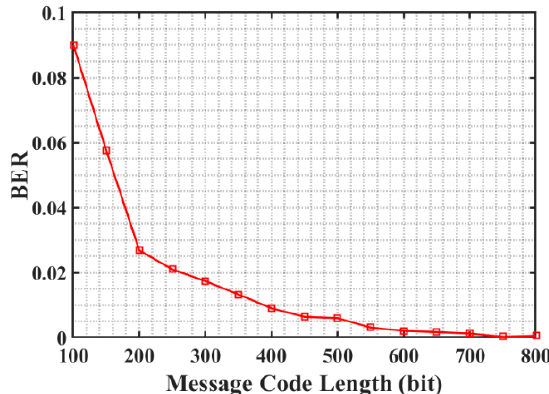
Figure 5. Variation curve of BER with information code length.